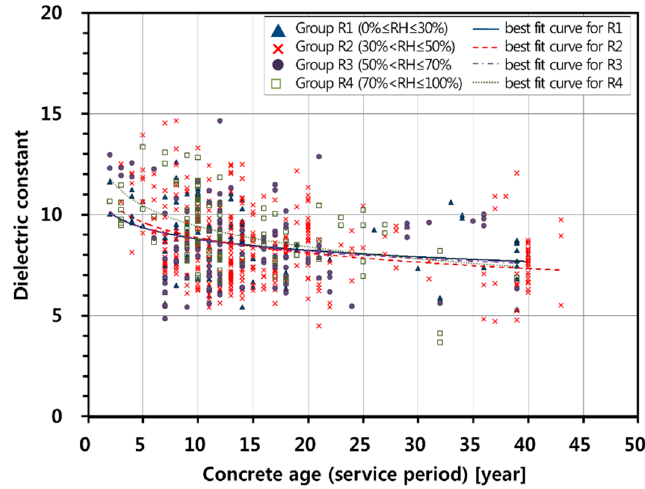
Figure 6. Variation of dielectric constant of asphalt-covered concrete bridge decks in the four bridge groups classified according to relative humidity: RH ≤ 30% (Group R1), 30% < RH ≤ 50% (Group R2),